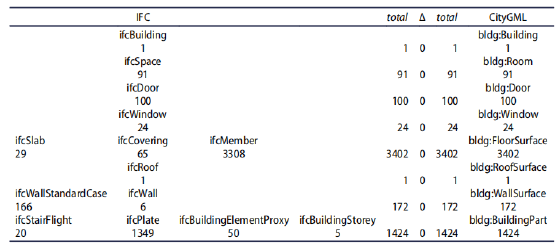
Figure 2. Validation elements from IFC into CityGML.